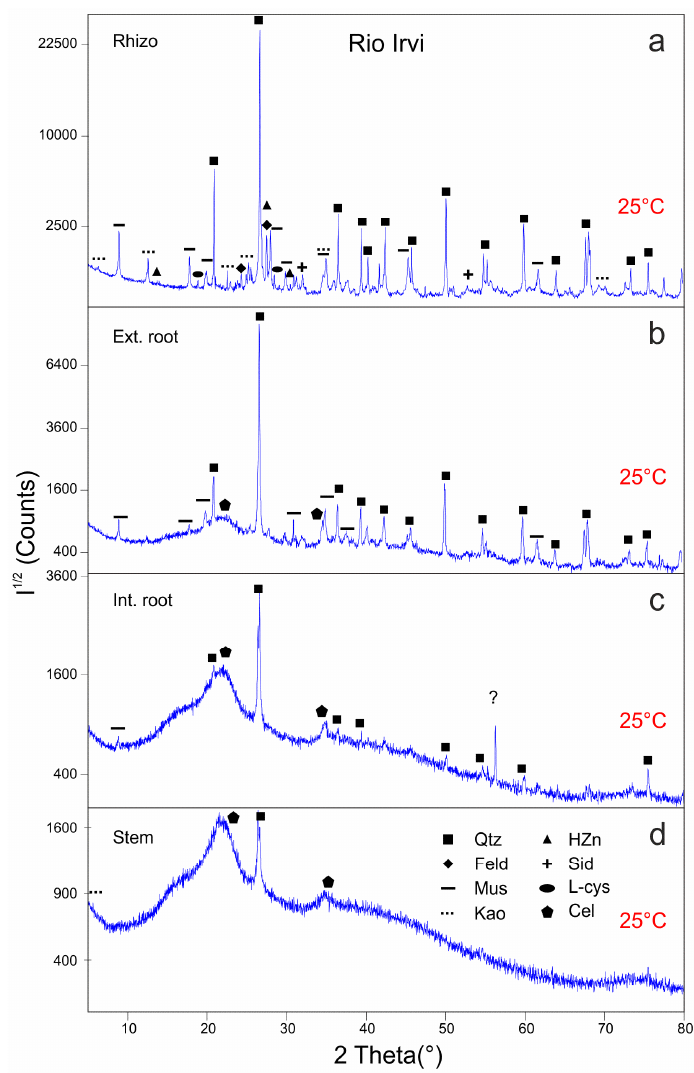
Figure 5. XRD patterns of samples from Rio Irvi collected before heating (25 °C): rhizosphere ( a ), external root ( b ), internal root ( c ), and stem ( d ). Intensities (I 1/2 ) are reported in a square root scale to highlight minor peaks. Abbreviations as in Tables 2 and 3. Question mark in ( c ) represents an unidentified peak probably due to an organic compound (see